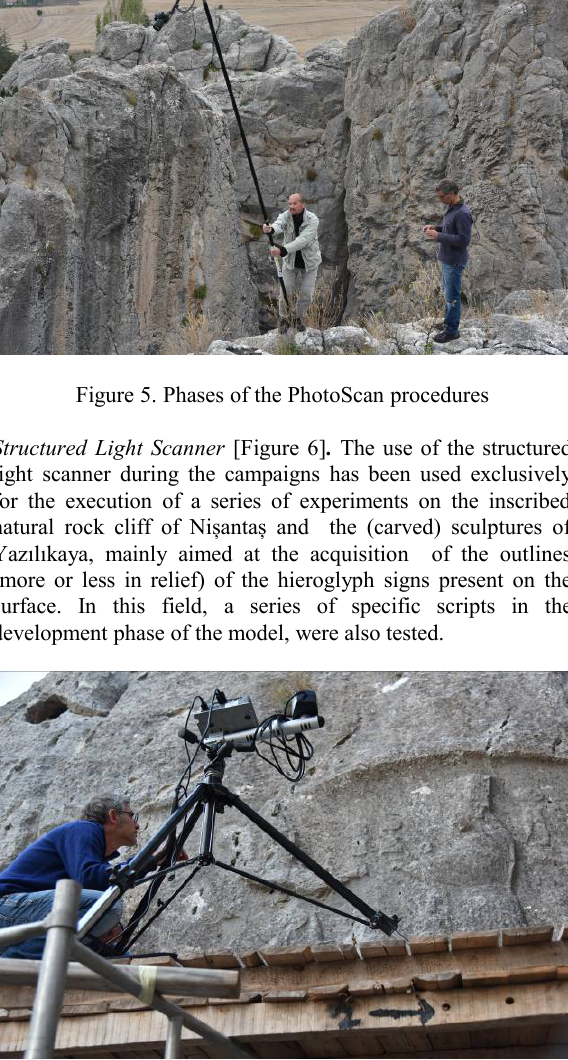
Figure 6. Structured Light acquisition